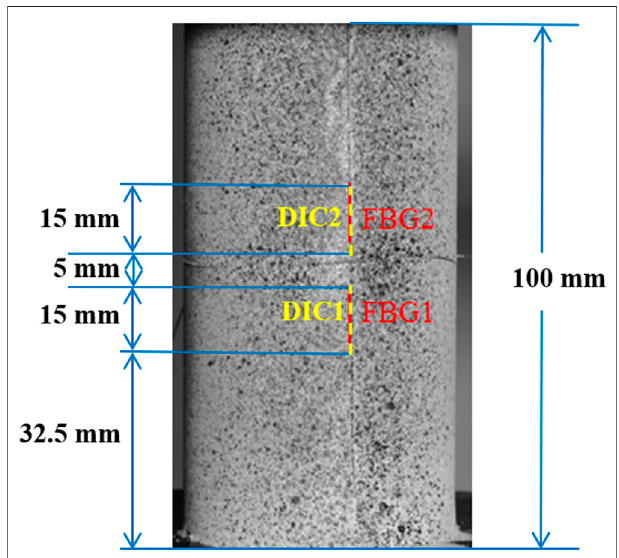
FIGURE 4 | Layout of DIC and FBG